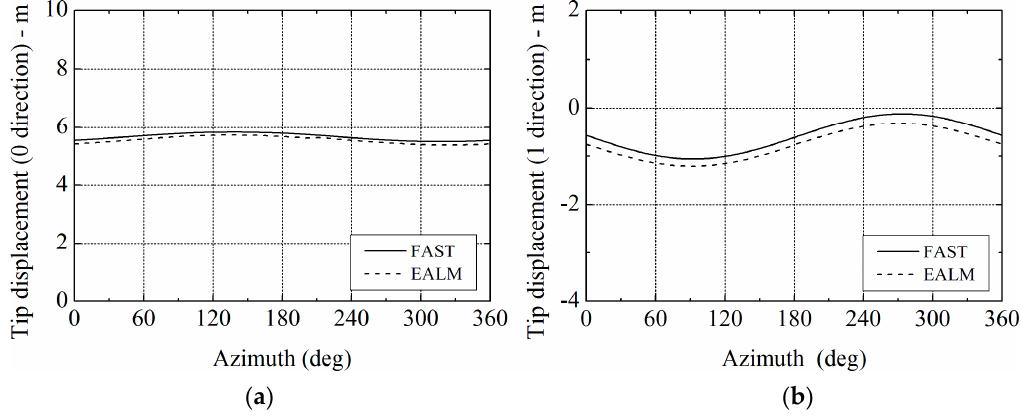
Figure 16. Comparison of azimuthal variations of blade tip deformations between elastic actuator line model (EALM) and NREL’s FAST code at 11.4 m/s: ( a ) in 0 direction; and ( b ) in 1 direction.